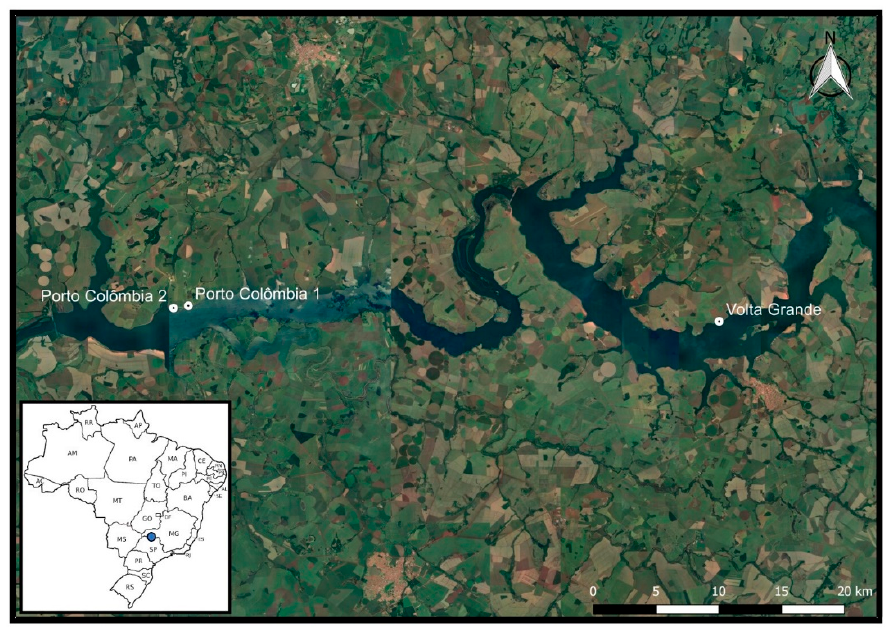
Figure 1. Location of the experimental units (EUs) in the hydroelectric power plants: Porto Colômbia 1 (20°6’55.82” S; 48°28’9.07” W), Porto Colômbia 2 (20°7’2.08” S; 48°28’49.78” W), and Volta Grande (20°7’38.86” S; 48°3’51.21” W). Table 1. Geotechnical characteristics of the experimental units.